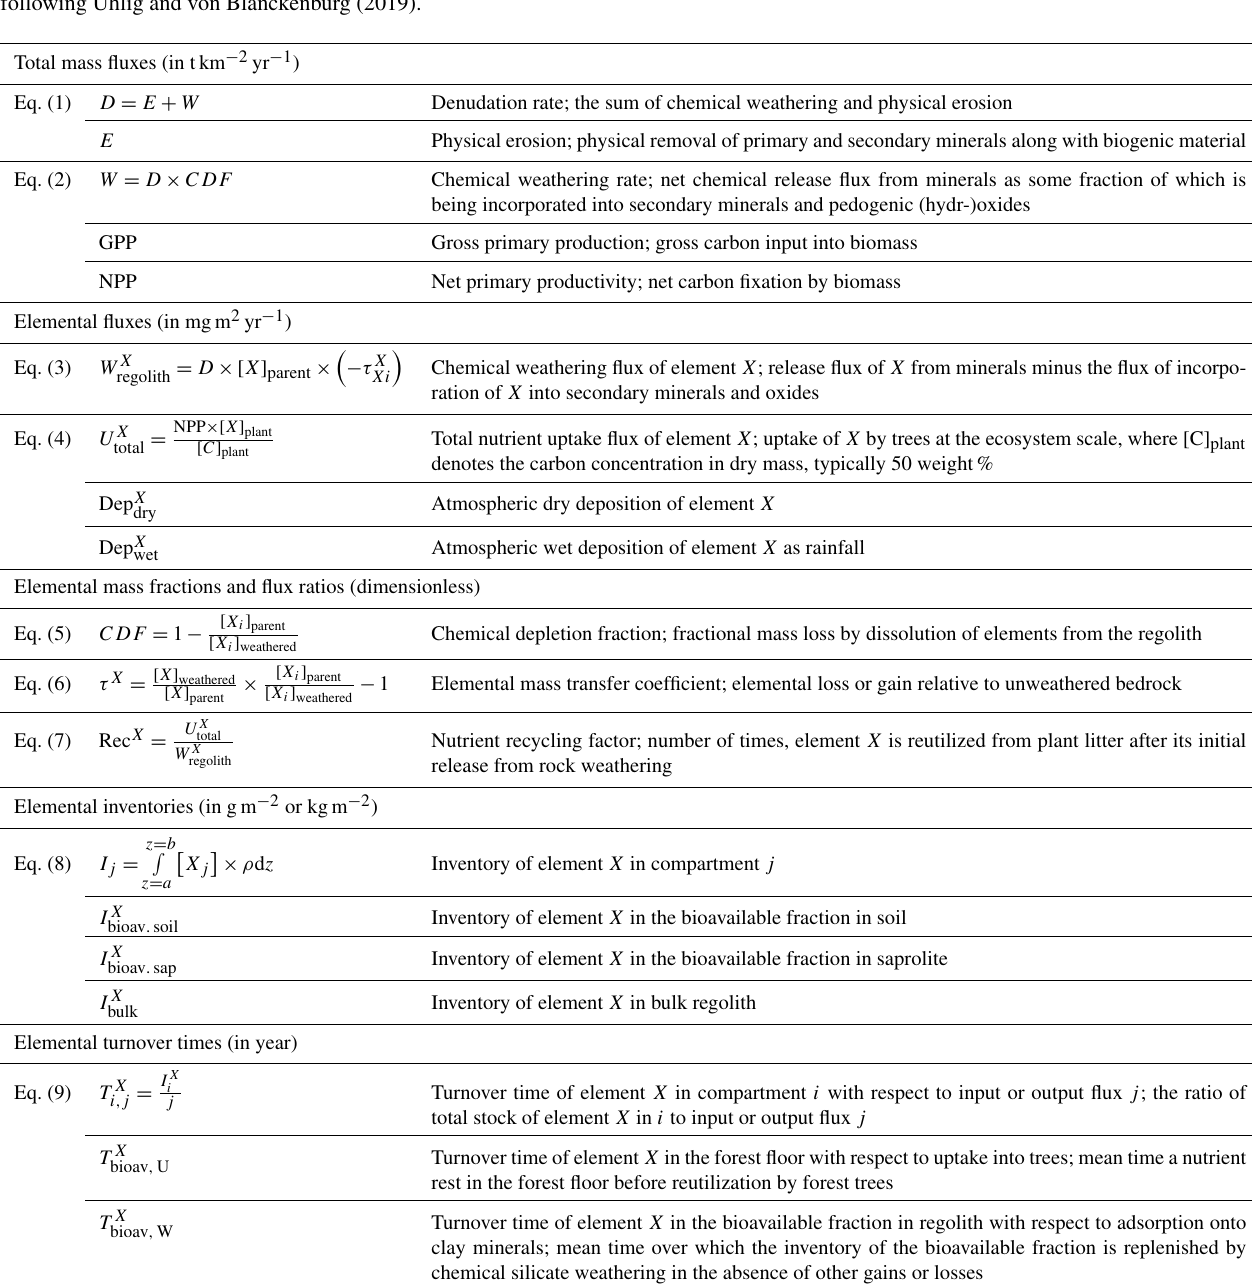
Table 2. Glossary of metrics for the parameterization of the geogenic nutrient pathway and organic nutrient cycle in terrestrial ecosystems following Uhlig and von Blanckenburg